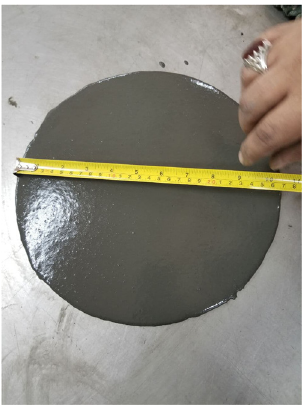
Figure 1: ( a ) Steel fi ber. ( b ) Polyole fi n fi ber.